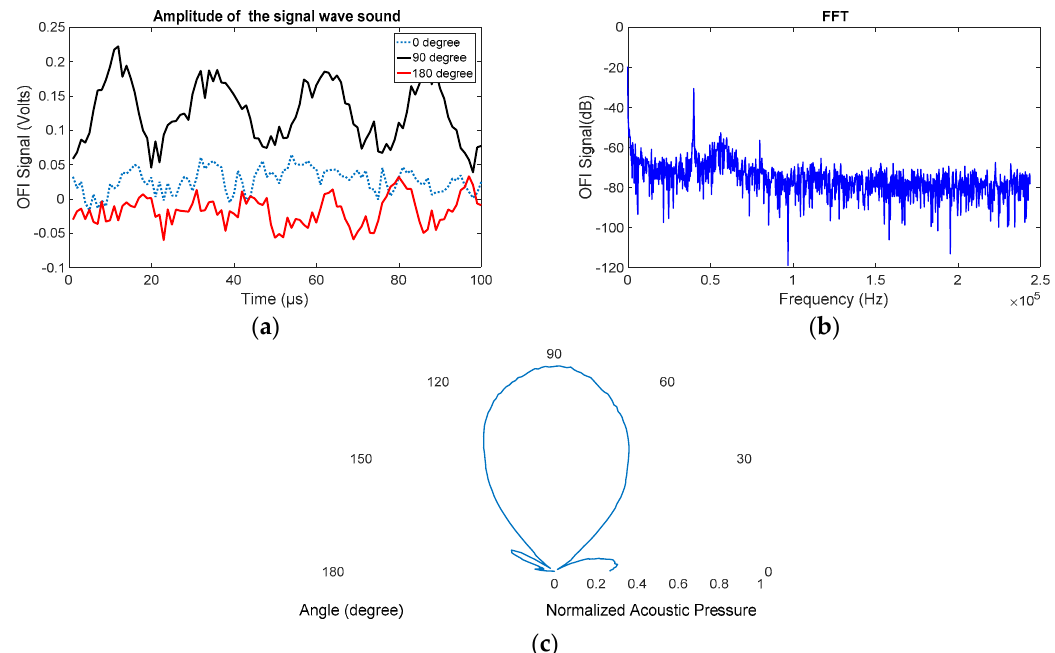
Figure 4. Measurement results. ( a )Time domain signals at 0° (blue dashedline), 90° (black line) and 180° (red line); ( b ) Frequency domain signal when the sound propagation is done towards the laser beam (corresponding to 90°); ( c )Normalized acoustic pressure radiation pattern of the MA40B8S ultrasonic piezoelectric